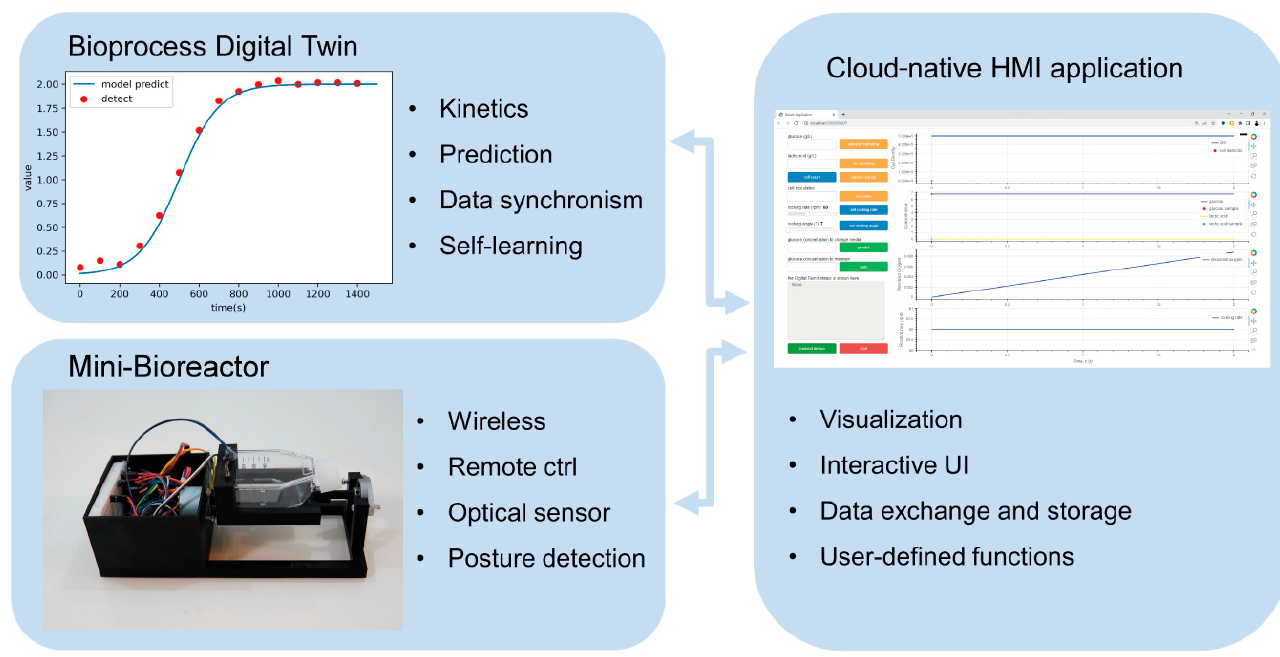
Figure 3. The architecture of the digital-twin-based cell culture system.